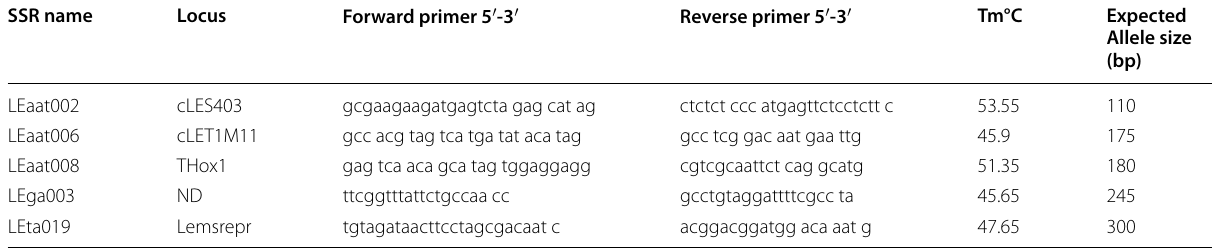
Table 2 The simple sequence repeat marker (SSR), their locus name, flanking primer sequence, melting temperature, and fragment sizes of the polymerase chain reaction (PCR) products